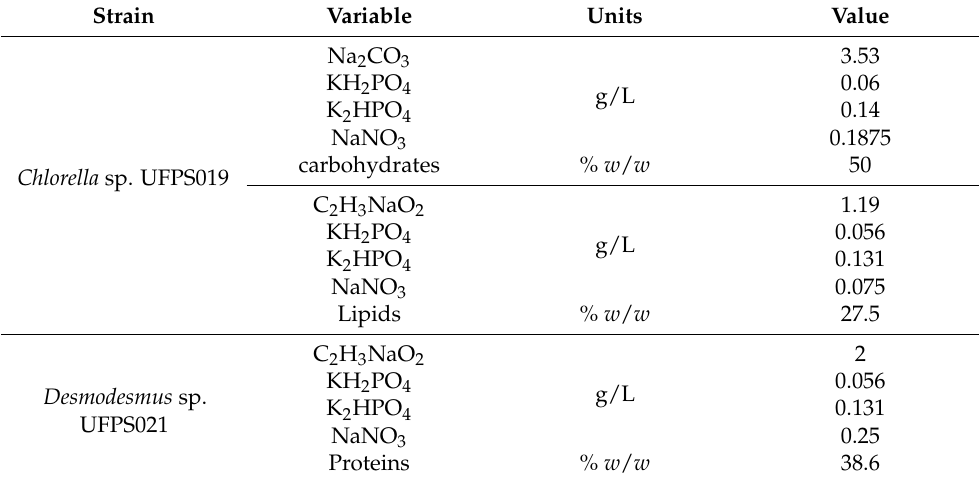
Table 3. Variables for optimal biomass concentration in both strains were studied.